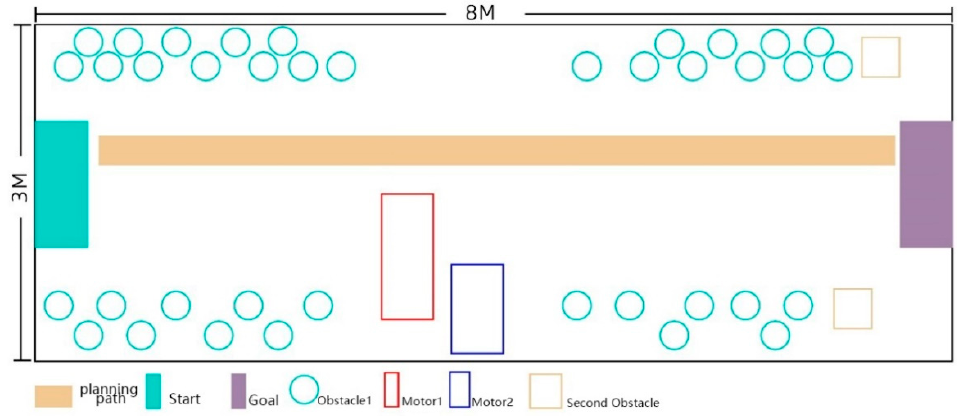
Figure 9. Path map of the inter-group comparison